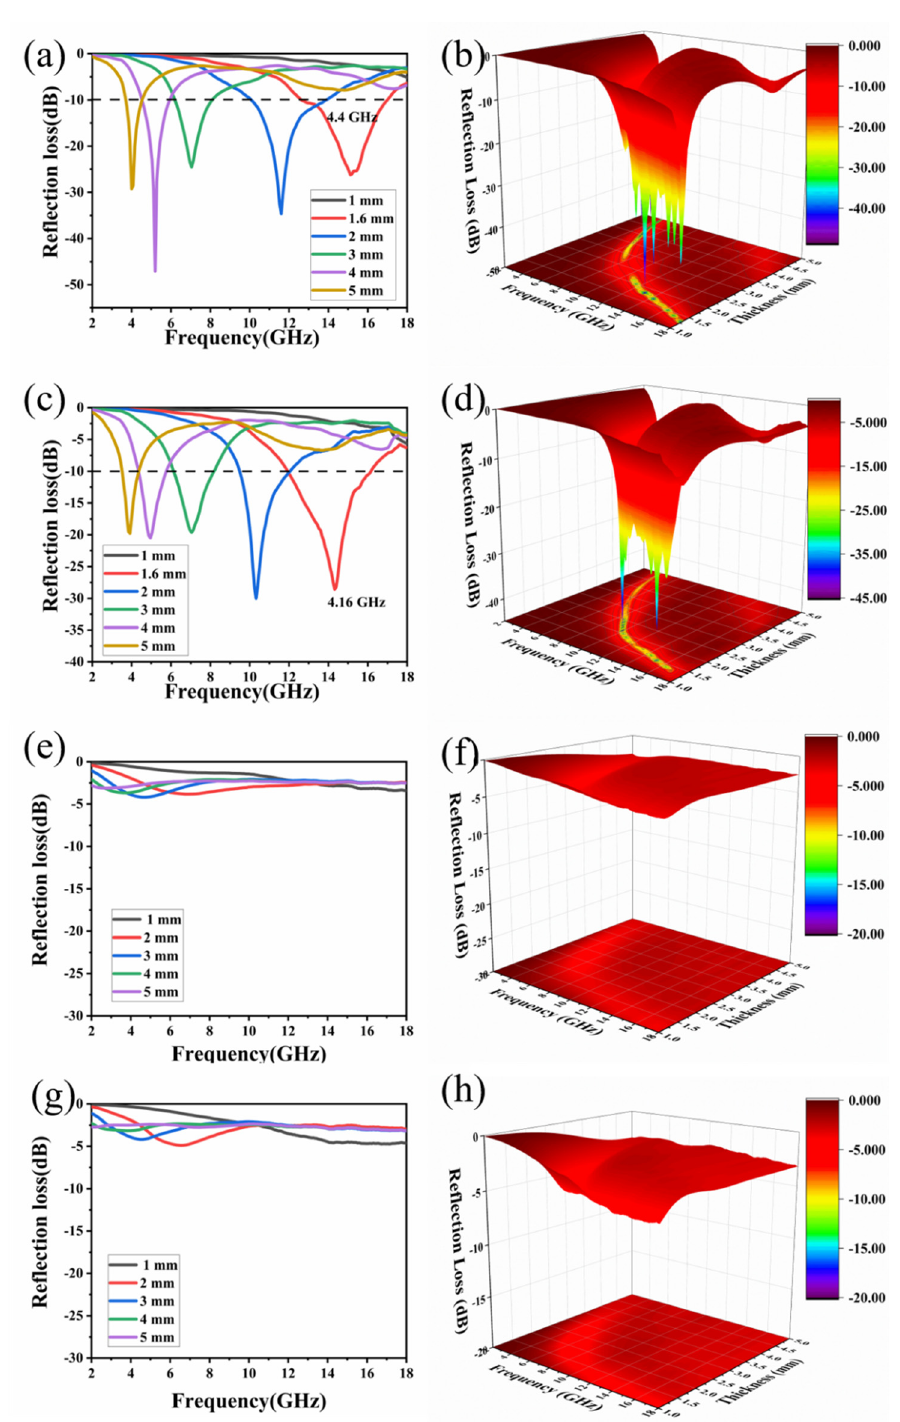
Figure 8. Reflection loss of ( a , b ) CuPc after 5% NaCl soaking, ( c , d ) CuPc after 10% NaCl soaking, ( e , f ) CuPc after 1 M HCl soaking, and ( g , h ) Pc.